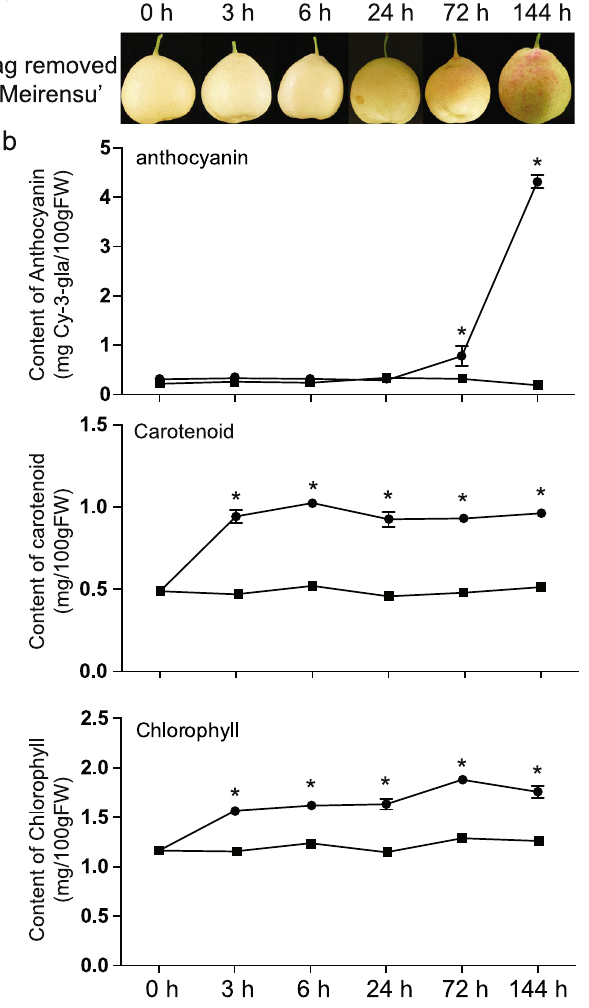
Figure 1. Changes in pigmentation of fruit peel of red Chinese sand pear in bagged and bag-removed samples. ( a ) Photos for bag-removed pear ‘Meirensu’. ( b ) Content changes of anthocyanin (up), carotenoid (middle) and chlorophyll (down) in fruit peel after bag removal. The labels of the samples were displayed as “hours after bag-removal” (h). The graphs showed the average values from three independently sampled fruits as biological replicates. Error bars are the standard deviation. Asterisk indicates p < 0.05.